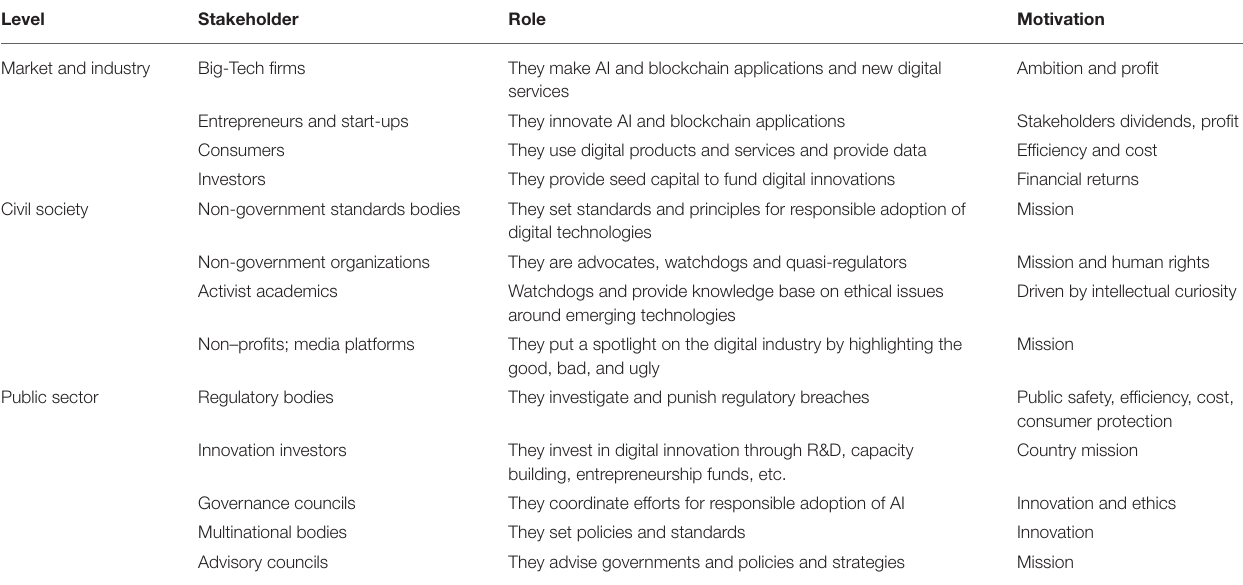
TABLE 1 | Emerging technology governance ecosystem